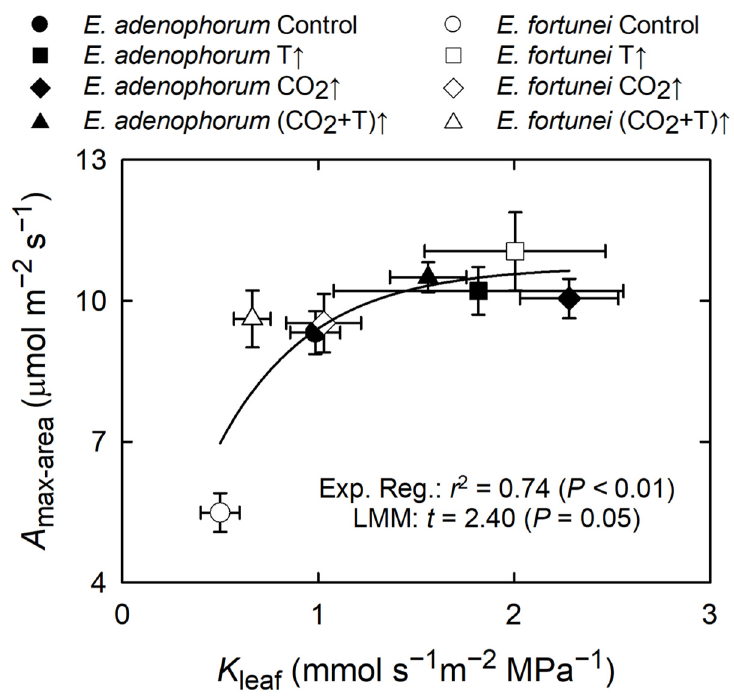
Figure 5. The relationship between leaf hydraulic conductance ( K leaf ) and light-saturated maximum photosynthetic rate per leaf area ( A a ). Points are means ± SE per treatment and species. The line indicate an exponential function. A linear mixed model (LMM) was also used to test the data with species as a random factor.